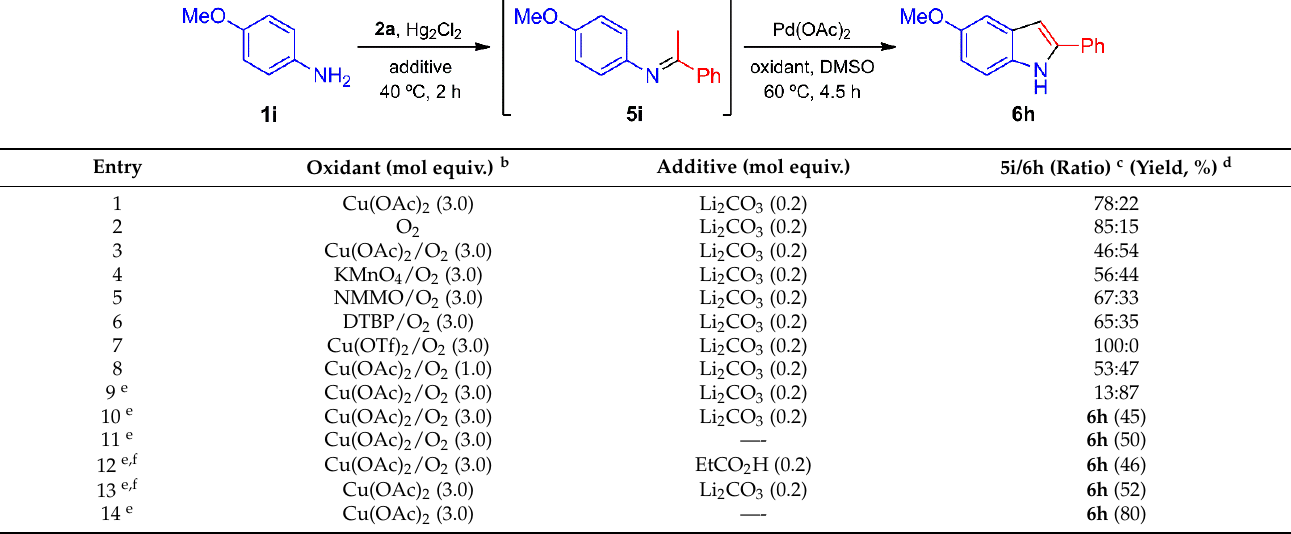
Table 3. Selection of the oxidizing agent and optimization of the reaction conditions for the one-pot conversion of 1i and 2a into indole 6h a .